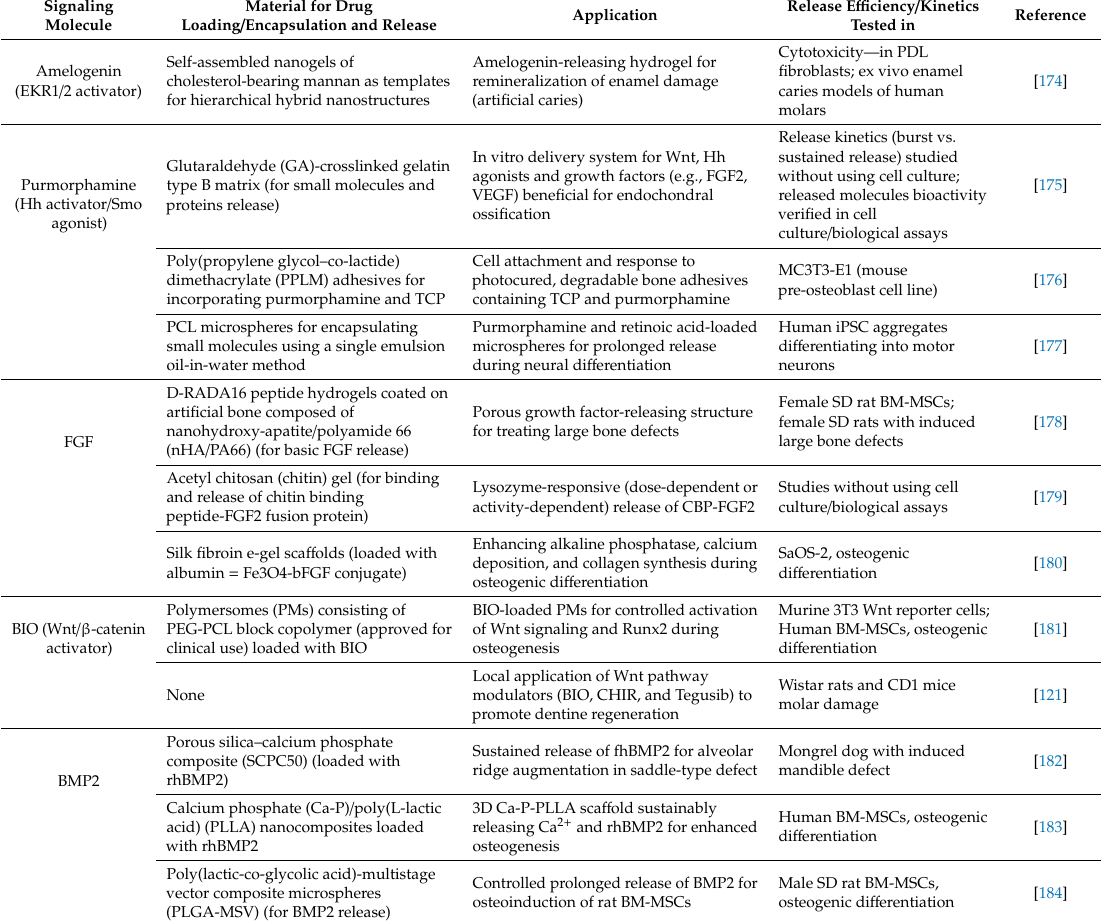
Figure 4. Release data of ( a ) adenosin triphosphate (ATP) and ( b ) suramin from agarose / hydroxyapatite (AG100HA0) (black), AG50HA50 (orange), and AG33HA67 (blue) sca ff olds. Data fit: Weibull equation. Reproduced from Witzler et al., 2019 [171]. Open Access Copyright Permission (Creative Commons CC BY license). Table 3. Materials applicable for loading, encapsulation and drugs / signaling molecules release for promoting cell proliferation, and di ff